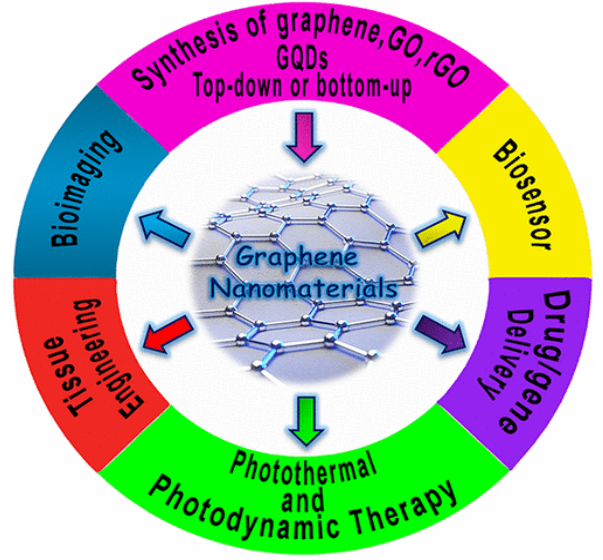
Figure 2. Applications of graphene nanomaterials in biomedical engineering. Reproduced from [40] with permission of the American Chemical Society.